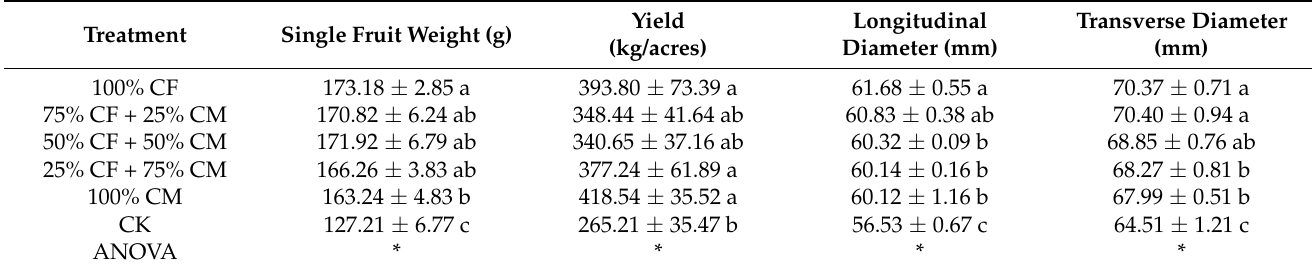
Table 2. Effect of different ratios of cow manure and chemical fertilizers on single fruit weight, yield, longitudinal diameter and transverse diameter.